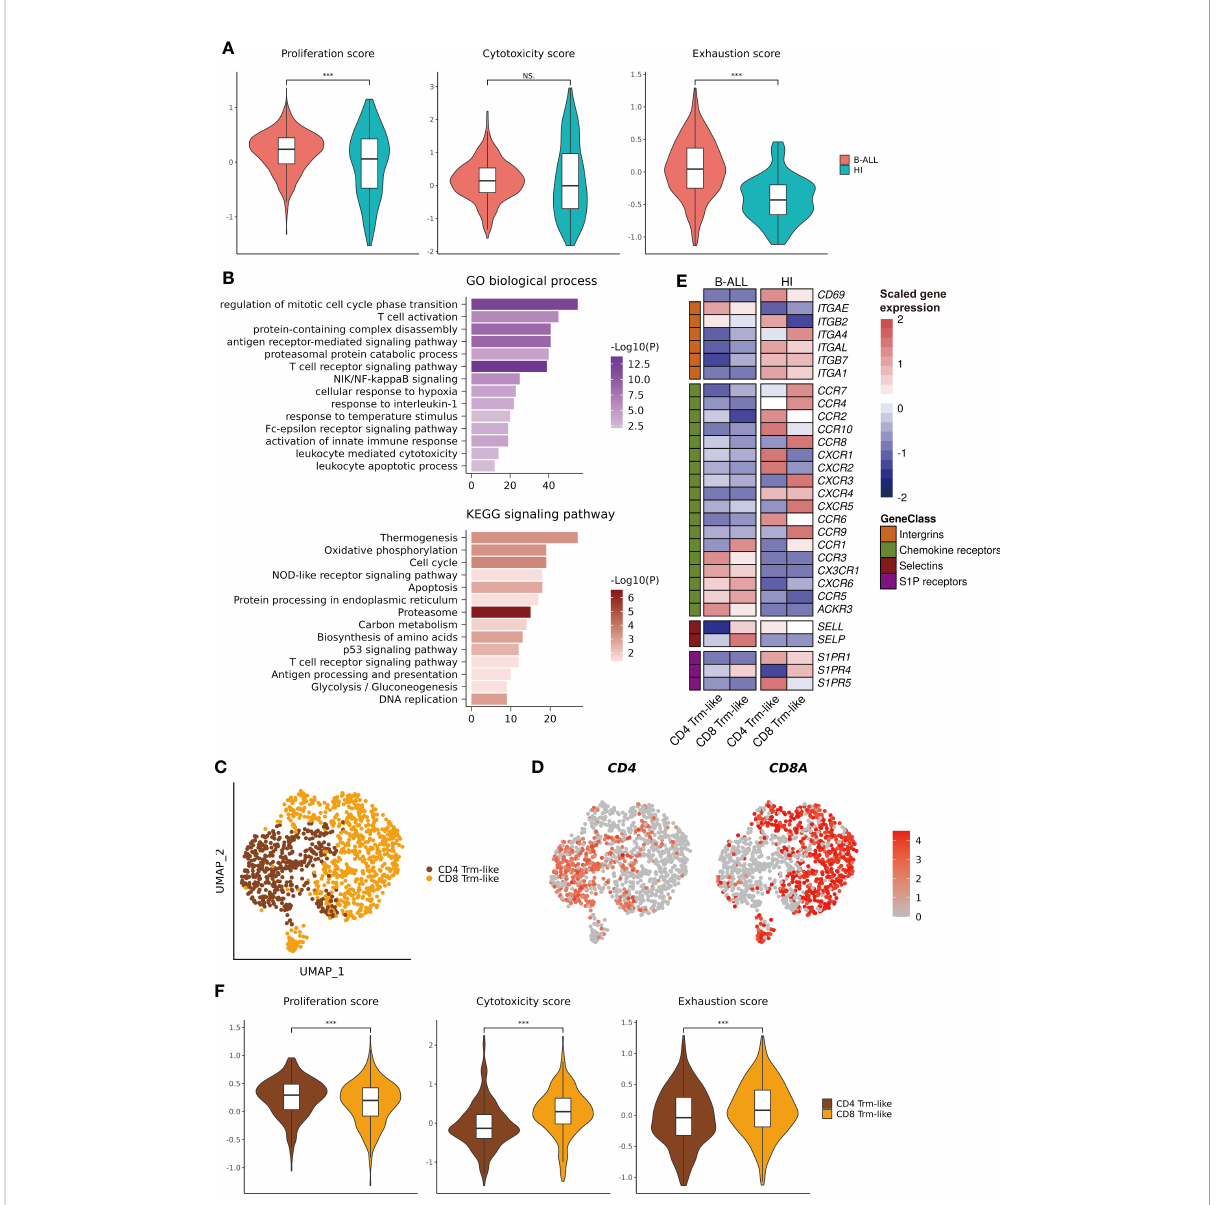
FIGURE 2 Functional characterization of Trm-like cells. (A). Single-cell transcriptome-derived Trm-like cell proliferation, cytotoxicity, and exhaustion score comparison between B-ALL patients and healthy individuals. (B). GO biological process (upper) and KEGG signaling pathway (lower) enrichment of upregulated genes in Trm-like cells of B-ALL patients in comparison to healthy individuals. (C). UMAP visualization of CD4+ and CD8+ Trm- like cells after reclustering of Trm-like cells from B-ALL patients and healthy individuals. (D). Projection of CD4 and CD8A expression level on Trm-like cells from B-ALL patients and healthy individuals. (E). Heatmap visualization of the expression of cell migration and chemotaxis-related genes in CD4+ and CD8+ Trm-like cells from B-ALL patients and healthy individuals. (F). Single-cell transcriptome-derived proliferation, cytotoxicity, and exhaustion score comparison between CD4+ and CD8+ Trm-like cells from B-ALL patients. For boxplots, the outlines of the boxes represent the fi rst and third quartiles. The line inside each box represents the median, and boundaries of the whiskers are found within the 1.5× IQR value. ***P <0.001; NS, not signi fi cant. Wilcoxon rank sum test